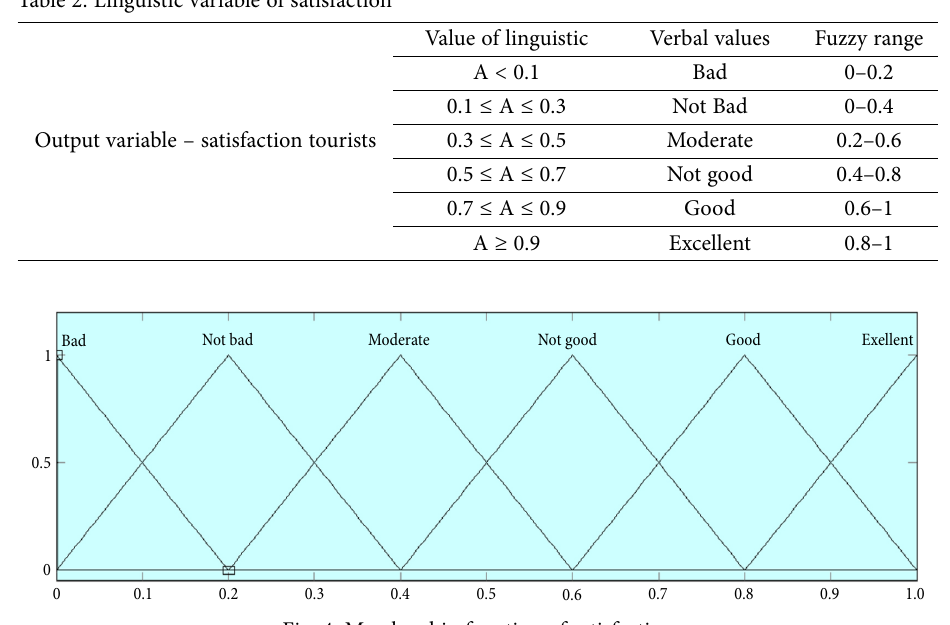
Fig. 4. Membership function of